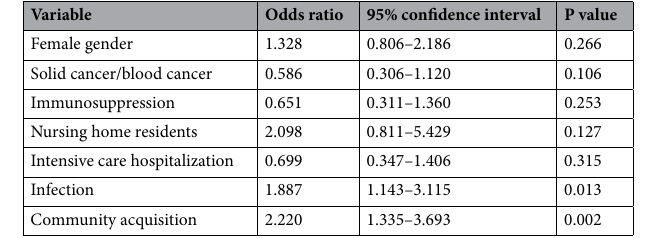
Table 3. Multivariate analysis of risk factors associated with CC131 ESBL-producing E. coli clinical isolates using logistic regression.